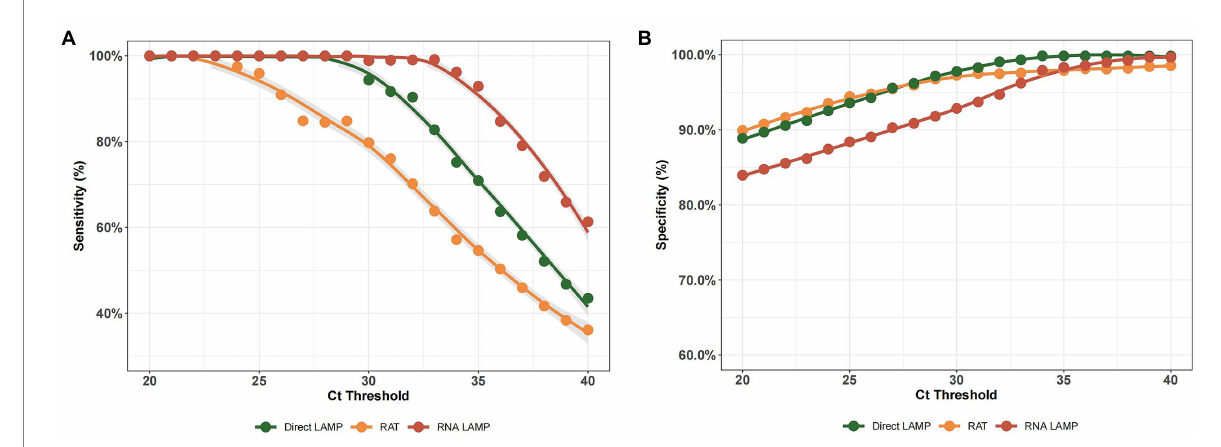
FIGURE 3 (A) The sensitivity of the RNA-LAMP assay, direct LAMP assay, and RAT with different RT-PCR cut-off values. (B) The specificity of the RNA-LAMP assay, direct LAMP assay, and RAT with different RT-PCR cut-off